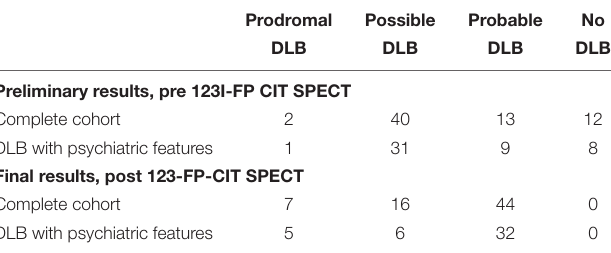
TABLE 2 | Frequency of DLB types in relation to 123I-FP-CIT